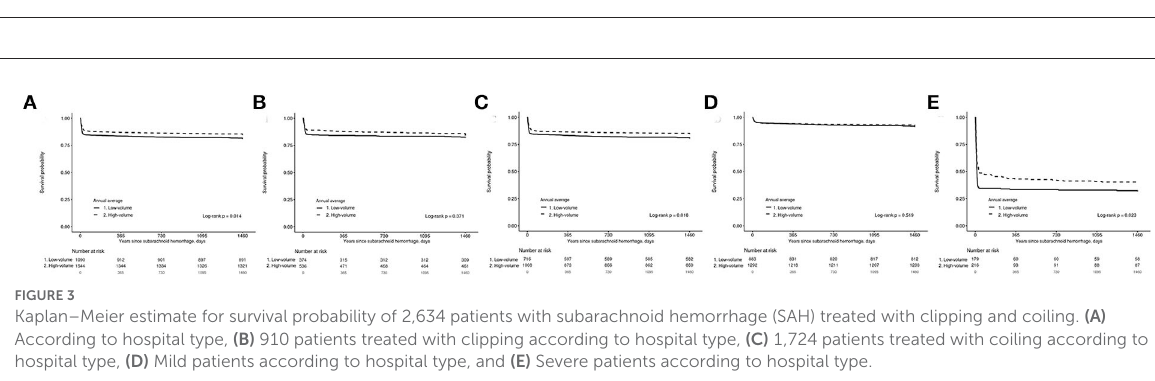
FIGURE2 The Kaplan–Meier estimate for survival probability of 2,634 patients with subarachnoid hemorrhage (SAH) treated with clipping and coiling. (A) According to age, (B) according to sex, (C) according to severity, and (D) according to clipping and coiling group.